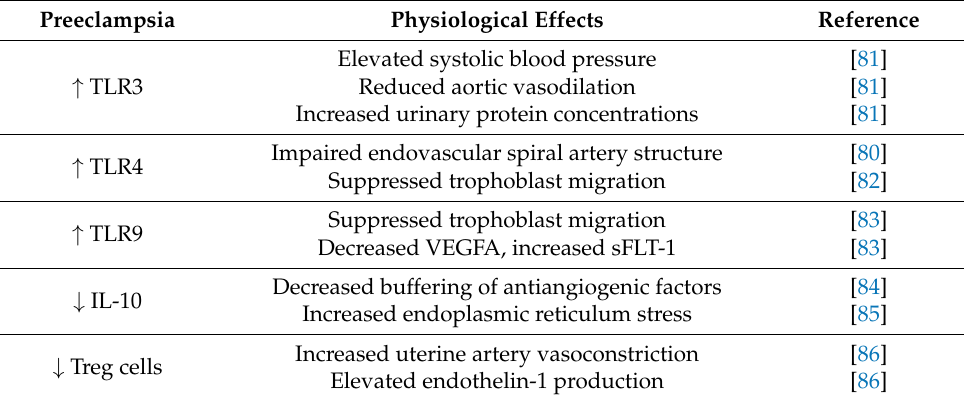
Table 1. Immune components altered in human preeclampsia and the effects of manipulation in cell culture and animal models.